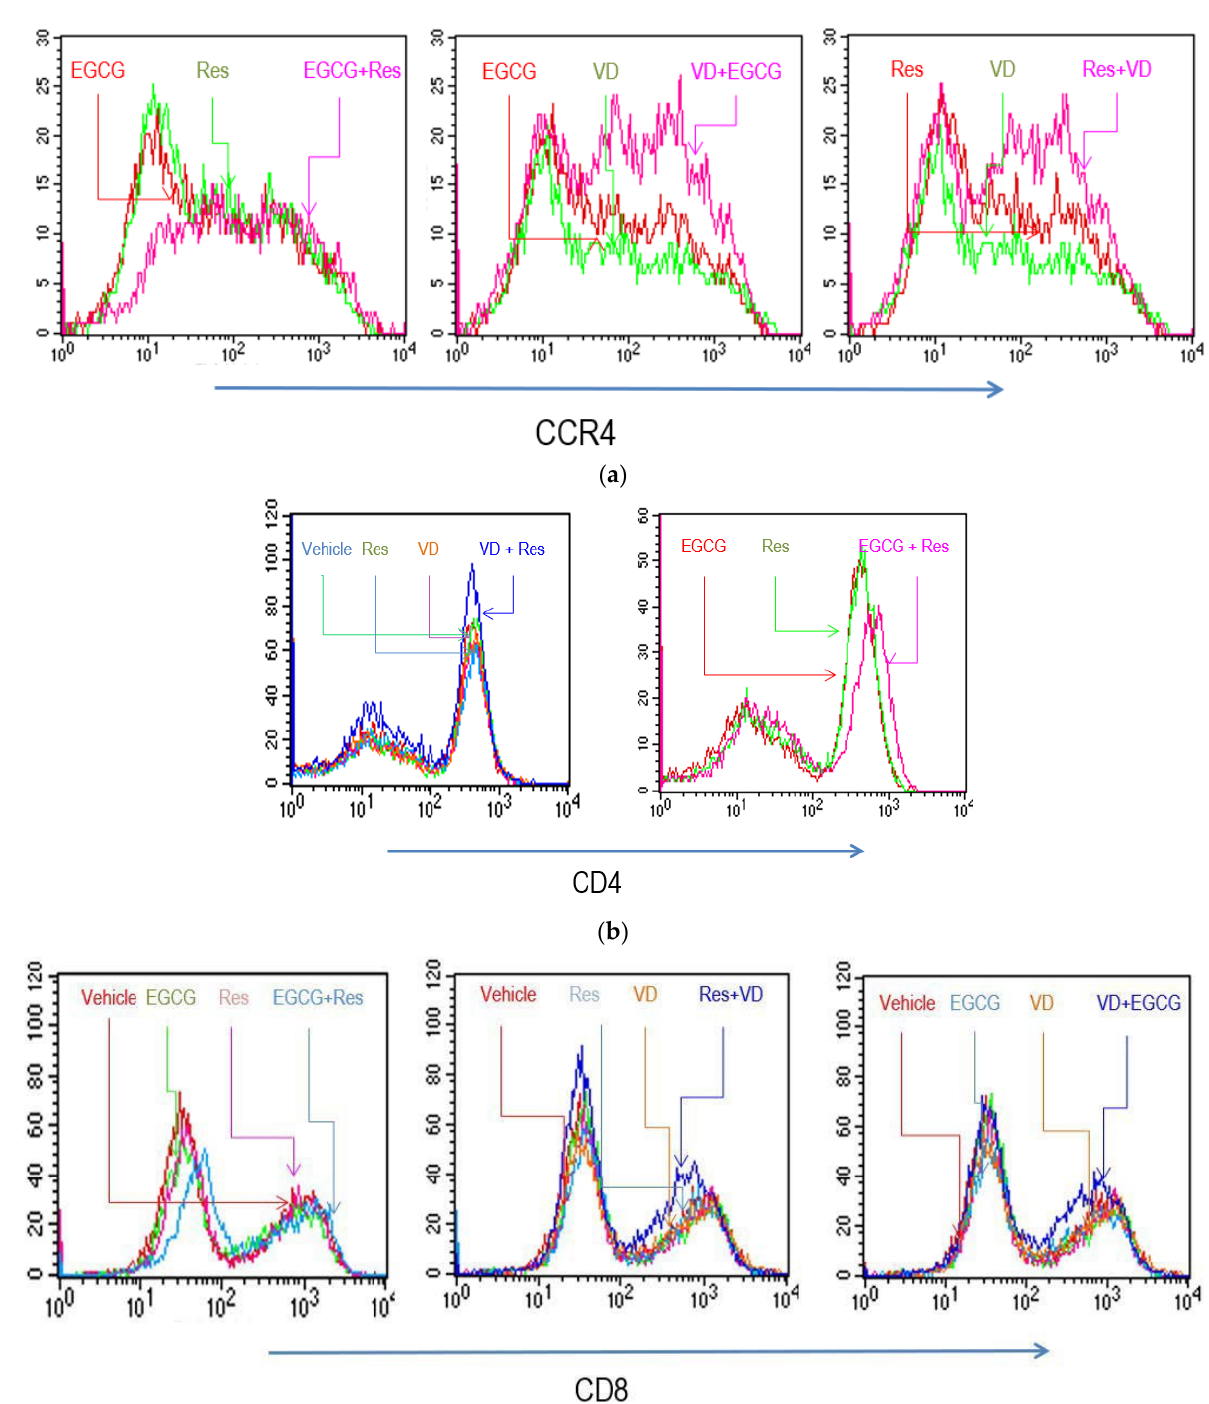
Figure 1. Influence of substances on lymphocyte surface determinants. Anti-CD3/CD28 activated PBMCs were cultured for 5 days, see [20], in the presence of indicated substances and the cytofluorometric profiles were determined. Where not indicated, similar staining pattern was observed in the absence of substances as with EGCG or Res. Cytofluorometric profiles were obtained by incubating cells with anti-CCR4 ( a ), anti-CD4 ( b ) and anti-CD8 ( c ).